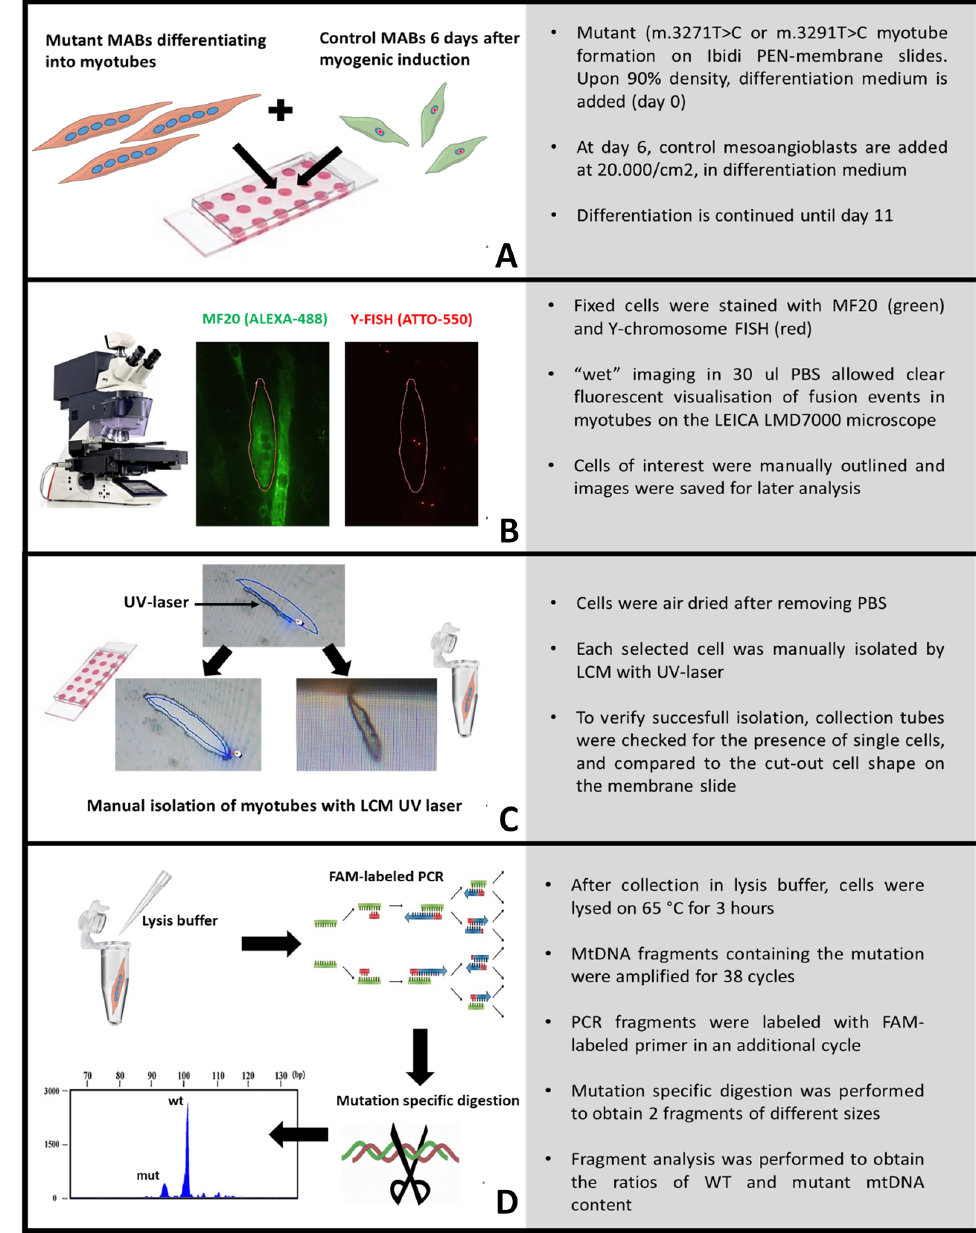
Figure 4. Schematic overview of fluorescent single-cell isolation and analysis. ( A ) mutant myotube culture and mixing of control MABs in Ibidi PEN-membrane slides for LCM, ( B ) representative images of selected cell-based multinucleated morphologies and subsequent selection on the presence of control nuclei (red Y-signal) in PBS, ( C ) laser capture process of selected cells after dehydration in brightfield mode, ( D ) cell manipulation protocol for subsequent mtDNA mutation load analysis.